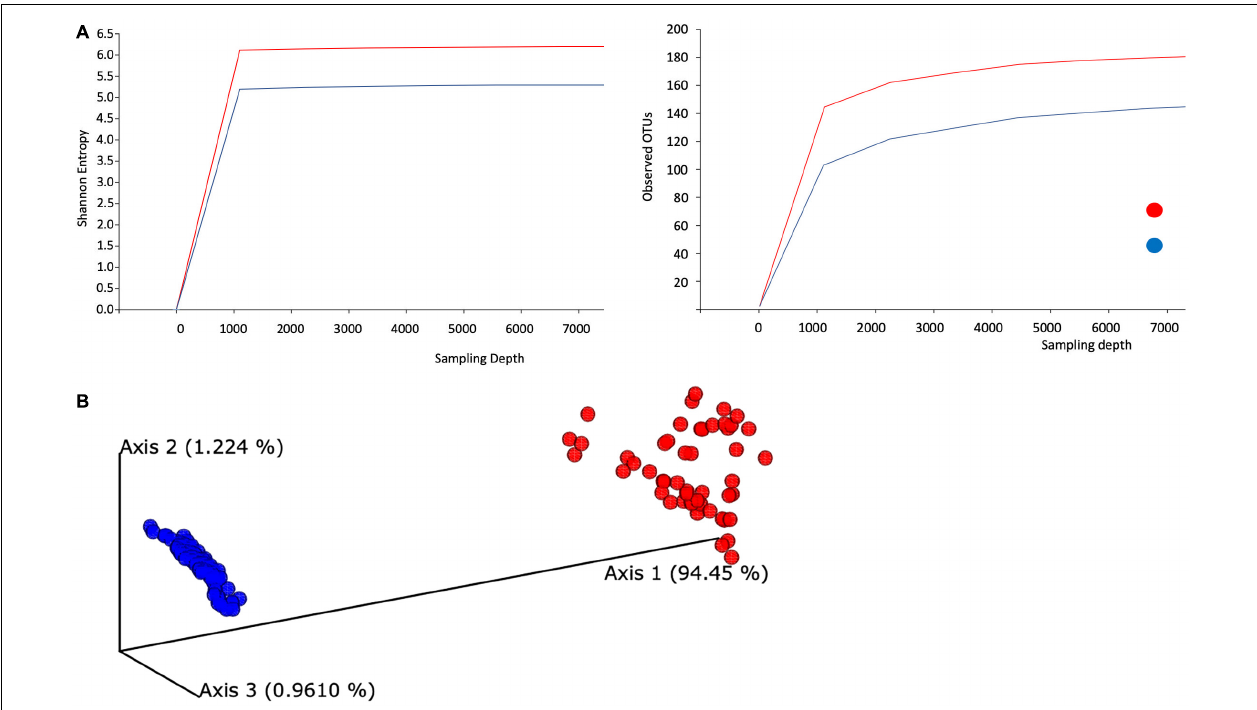
FIGURE 1 | Evaluation of the alpha- and beta-diversity of the gut microbiota of SARS-CoV-2-infected subjects. (A) Evaluation of alpha-diversity in the 143 analyzed samples. The outlined graphs report the average rarefaction curves based on Shannon entropy and raw count of features increasing sequencing depth of SARS-CoV-2-infected and SARS-CoV-2-non-infected samples. (B) Evaluation of beta-diversity. The panel shows the predicted principal coordinate analysis (PCoA) plot based on weighted UniFrac distances. SARS-CoV-2-infected and SARS-CoV-2-non-infected sample datasets are colored in red and blue,